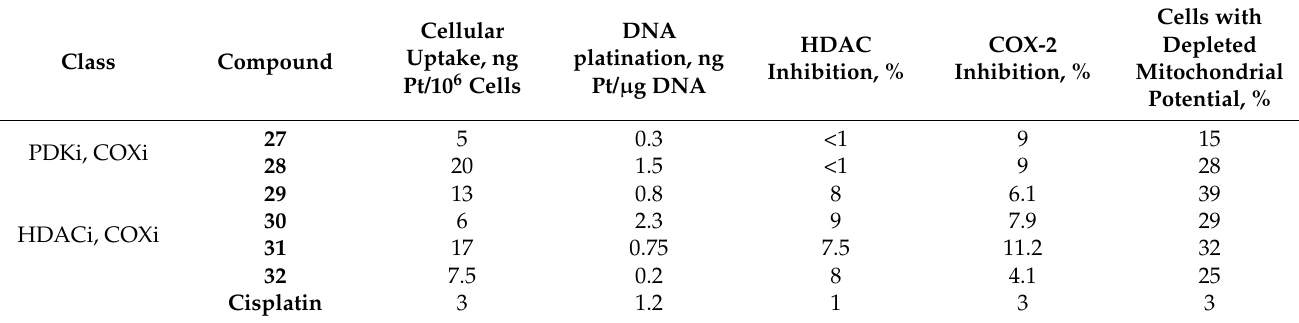
Table 17. Cellular uptake, DNA platination, and the ability of prodrugs 27–32 to inhibit HDAC and COX-2 and cause mitochondria depolarization in PSN-1 (pancreas cancer)